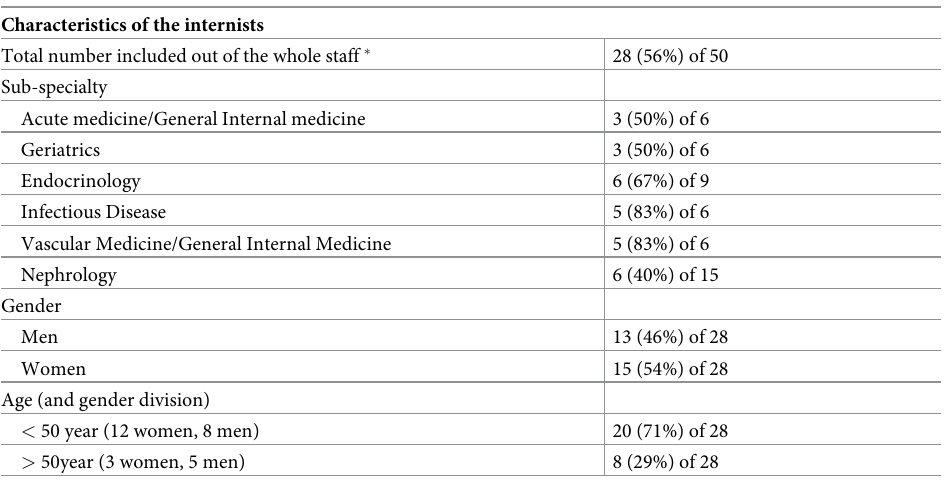
Table 1. Characteristics of the responding